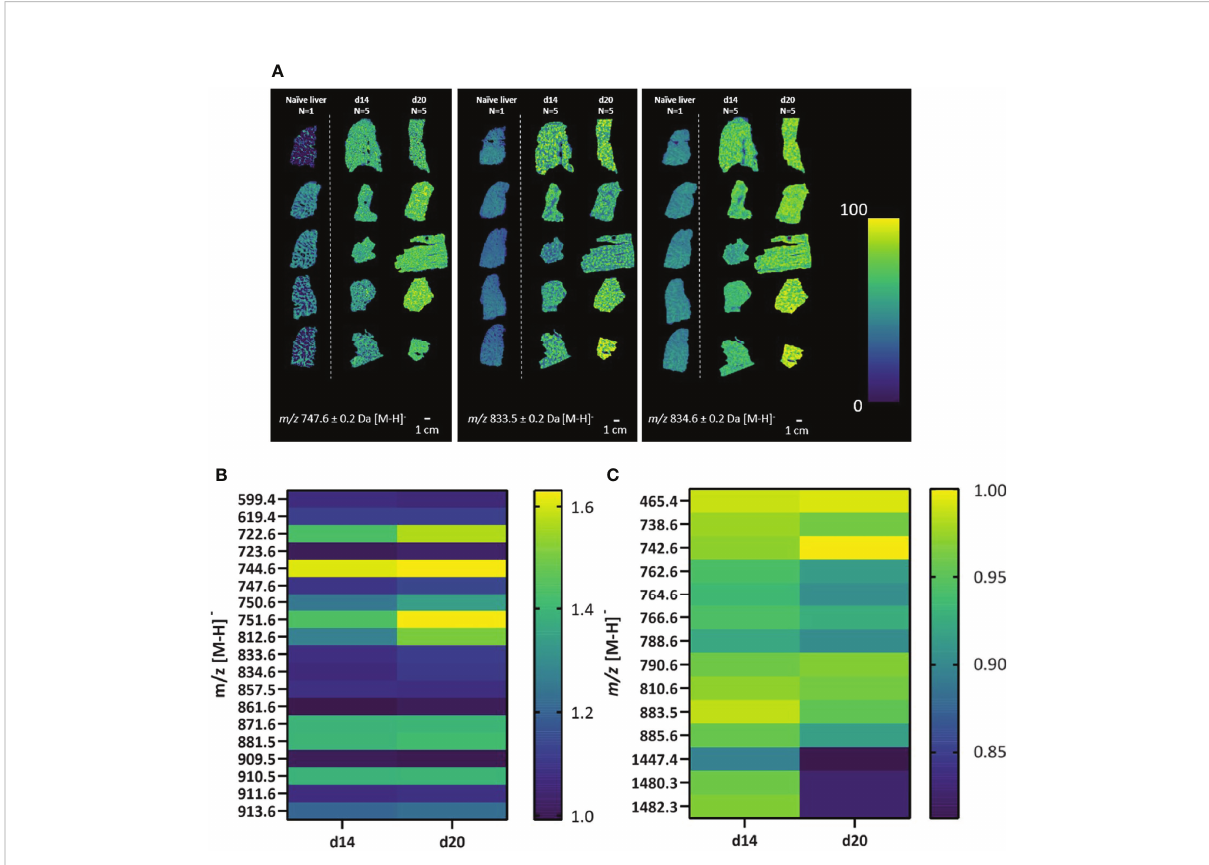
FIGURE 2 Alteration in lipid masses in naïve and L. donovani -infected mouse liver. Liver sections from L. donovani- infected C57BL/6 mice at d14 and d20 p.i. were compared to sections from naïve liver. (A) Spatial distributions of the relative abundance of three representative lipid masses (± 0.2 Da) in naïve, d14 and d20 livers. (B, C) Intensities of lipid masses increased in abundance (B) or decreased in abundance (C) in d14 (n=5) and d20 (n=5) mouse livers. Data are shown as relative mean fold change in infected vs naïve samples, as indicated in scale